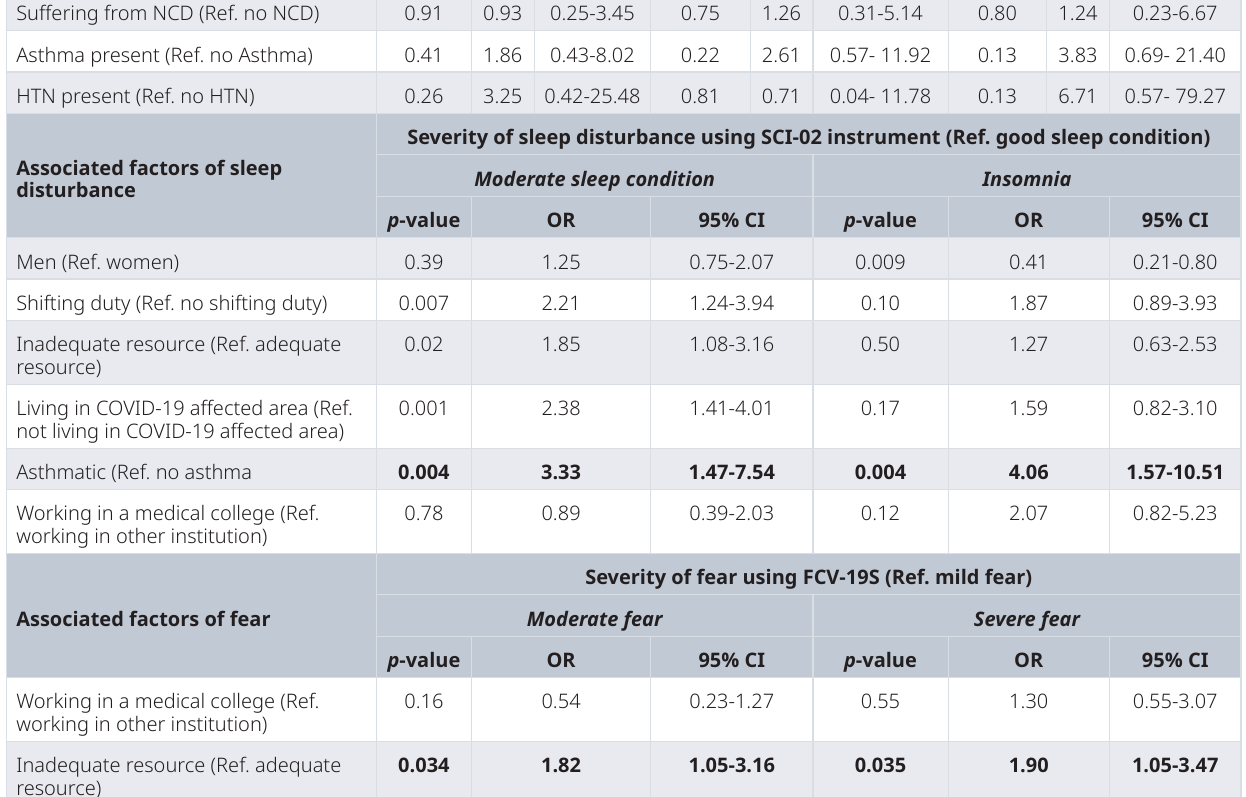
Inadequate resource (Ref. adequate